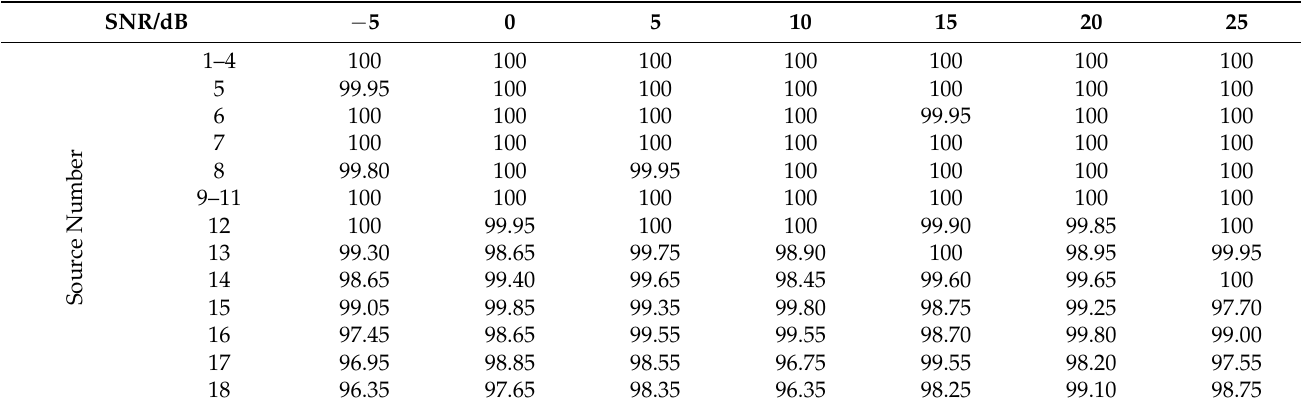
Table 5. Consistency rates of sparse array source number estimation at different